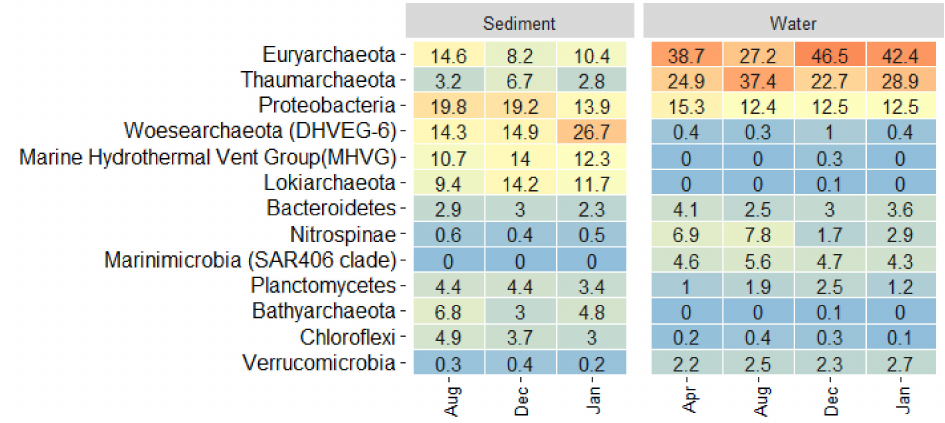
Figure 6. Heatmap showing the relative contribution of top representative phyla facet by biomes and sampling periods (January–December are upwelling periods). Orange versus light blue colors indicate a higher versus lower contribution,